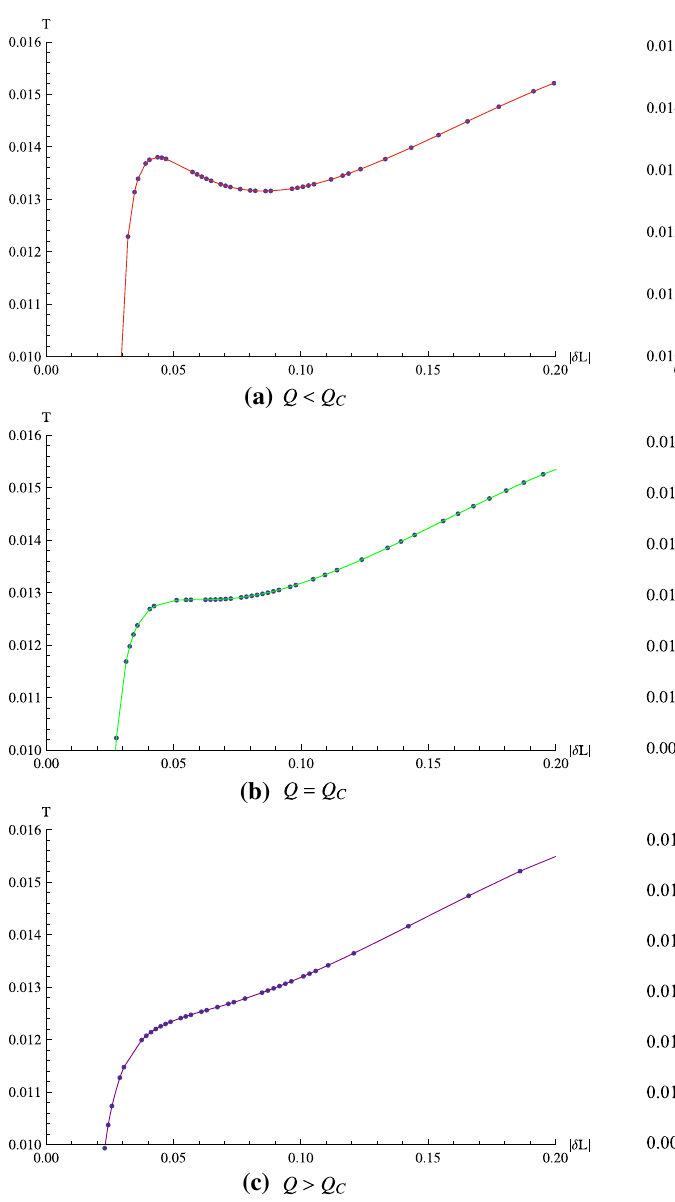
Fig. 8 T − | δ L | diagram for different values α for the neutral Gauss– Bonnet AdS black hole. Here we set parameters, l = 20, θ 0 = 0 . 50 and θ = 0 . C